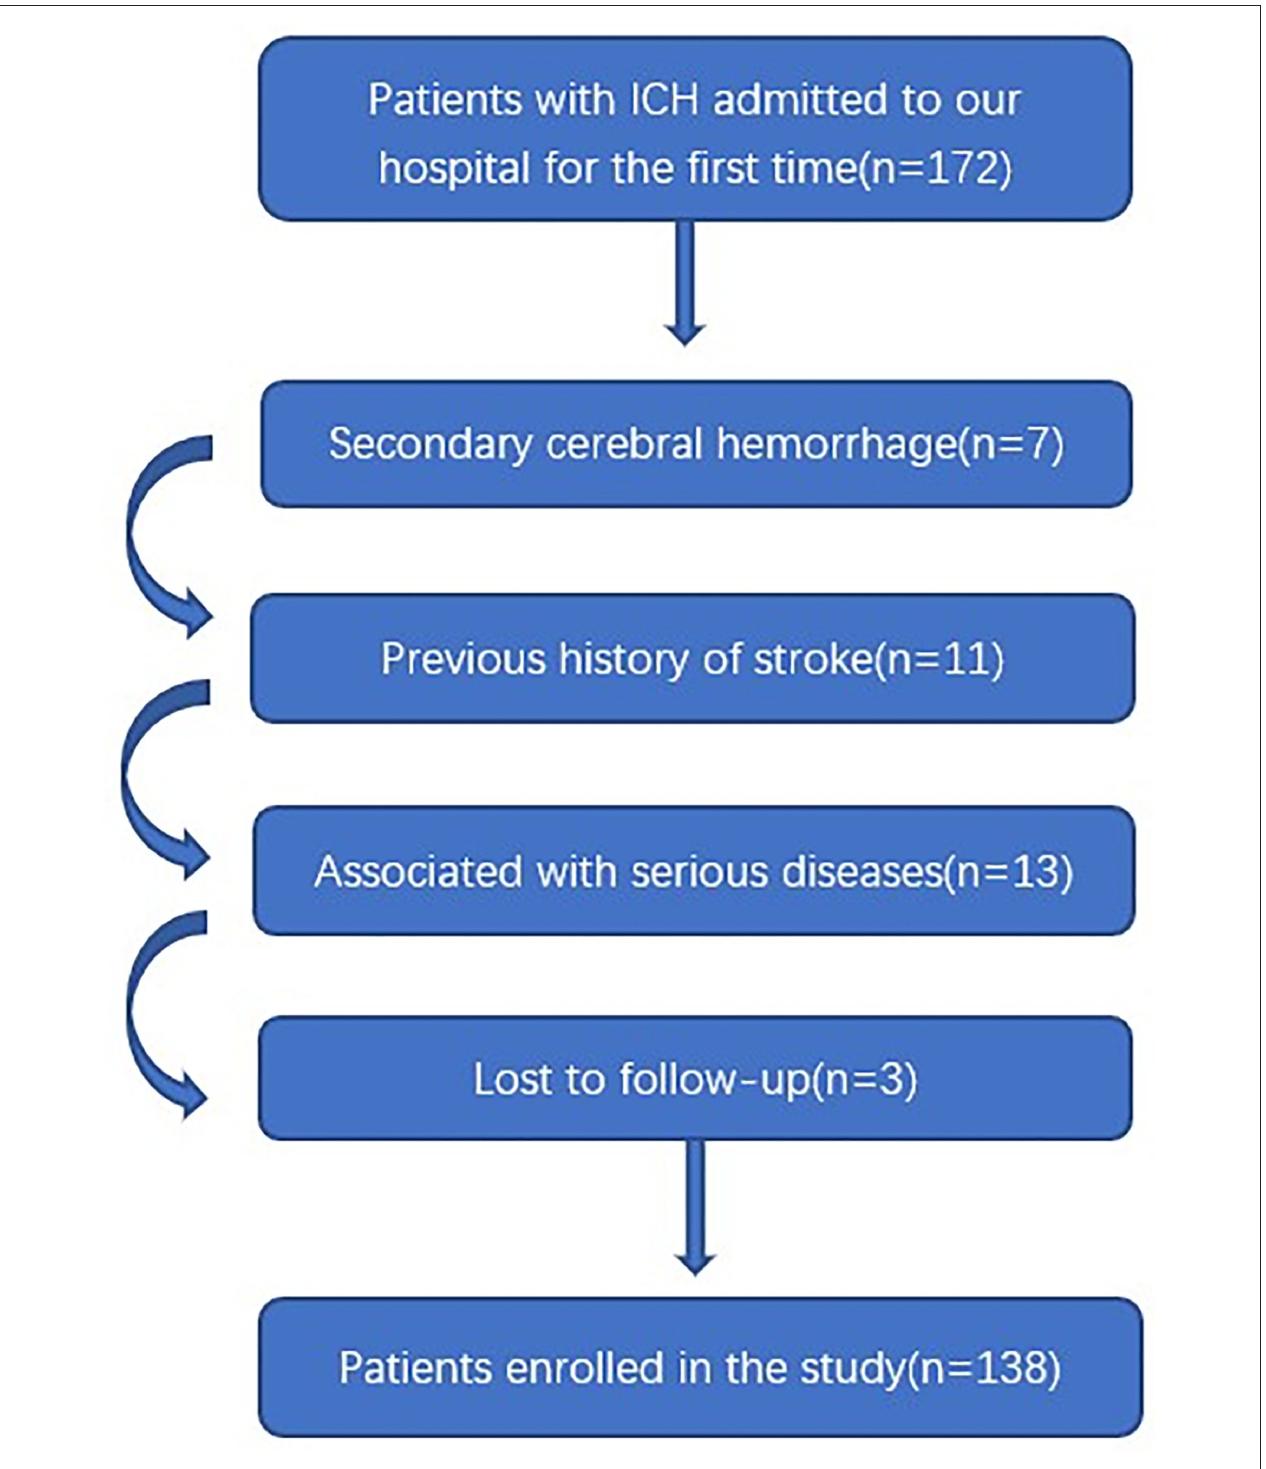
FIGURE 1 | Flowing chart for screening eligible patients with intracerebral hemorrhage. ICH indicates intracerebral hemorrhage.